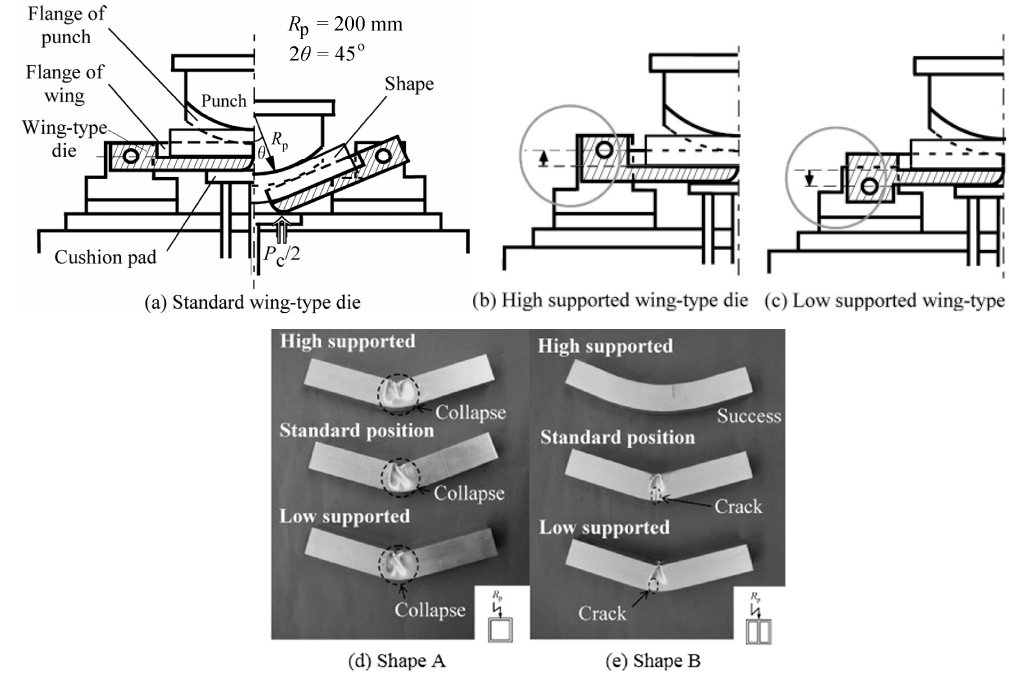
Figure 10. Appearance of shapes after press bending with different support positions of wing-type dies [48]. Multi-point forming (MPF), which was initially developed to form sheet metal parts, has been used to bend hollow A6N01S-T5 profiles [50]. MPF is a flexible manufacturing process with reduced time and costs for die design and fabrication. In MPF, as shown in Figure 11a, a series of discrete punch elements are used to replace the conventional solid dies. The contour shape of the punch matrix can be varied freely as the height of each punch element is independently controlled. By adjusting the relative height of each punch element, the shape contour of the punch matrices is formed to bend the profiles. Figure 11b shows the cross-sectional distortion of an A6N01S-T5 profile (bending radius 2000 mm) in MPF with different levels of inner pressure [51]. It indicates that the inner pressure can effectively restrain the cross-sectional distortion, although the defect is not